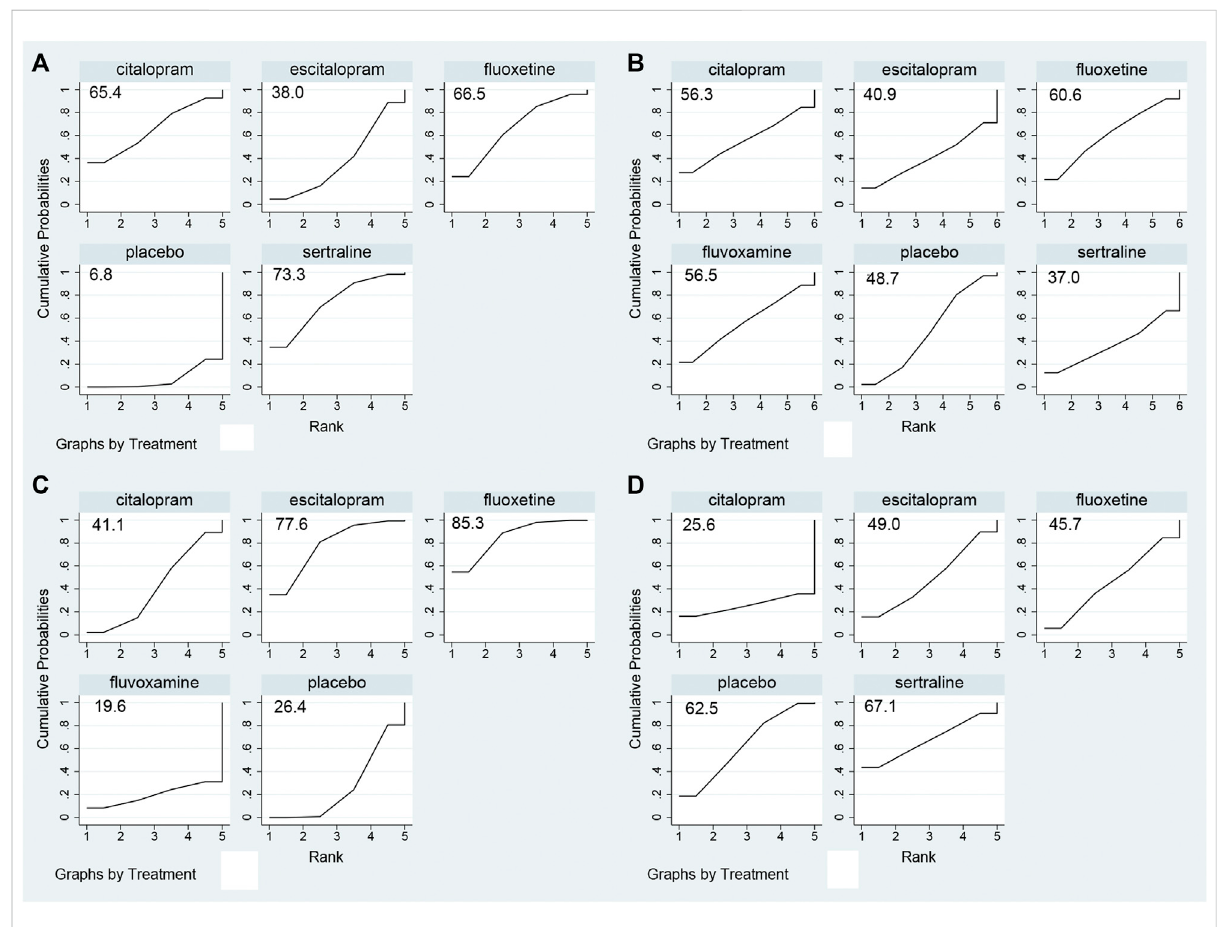
FIGURE 3 Summary of results from SUCRA. (A) Binge frequency; (B) Dropout rate; (C) HAMD score; (D)